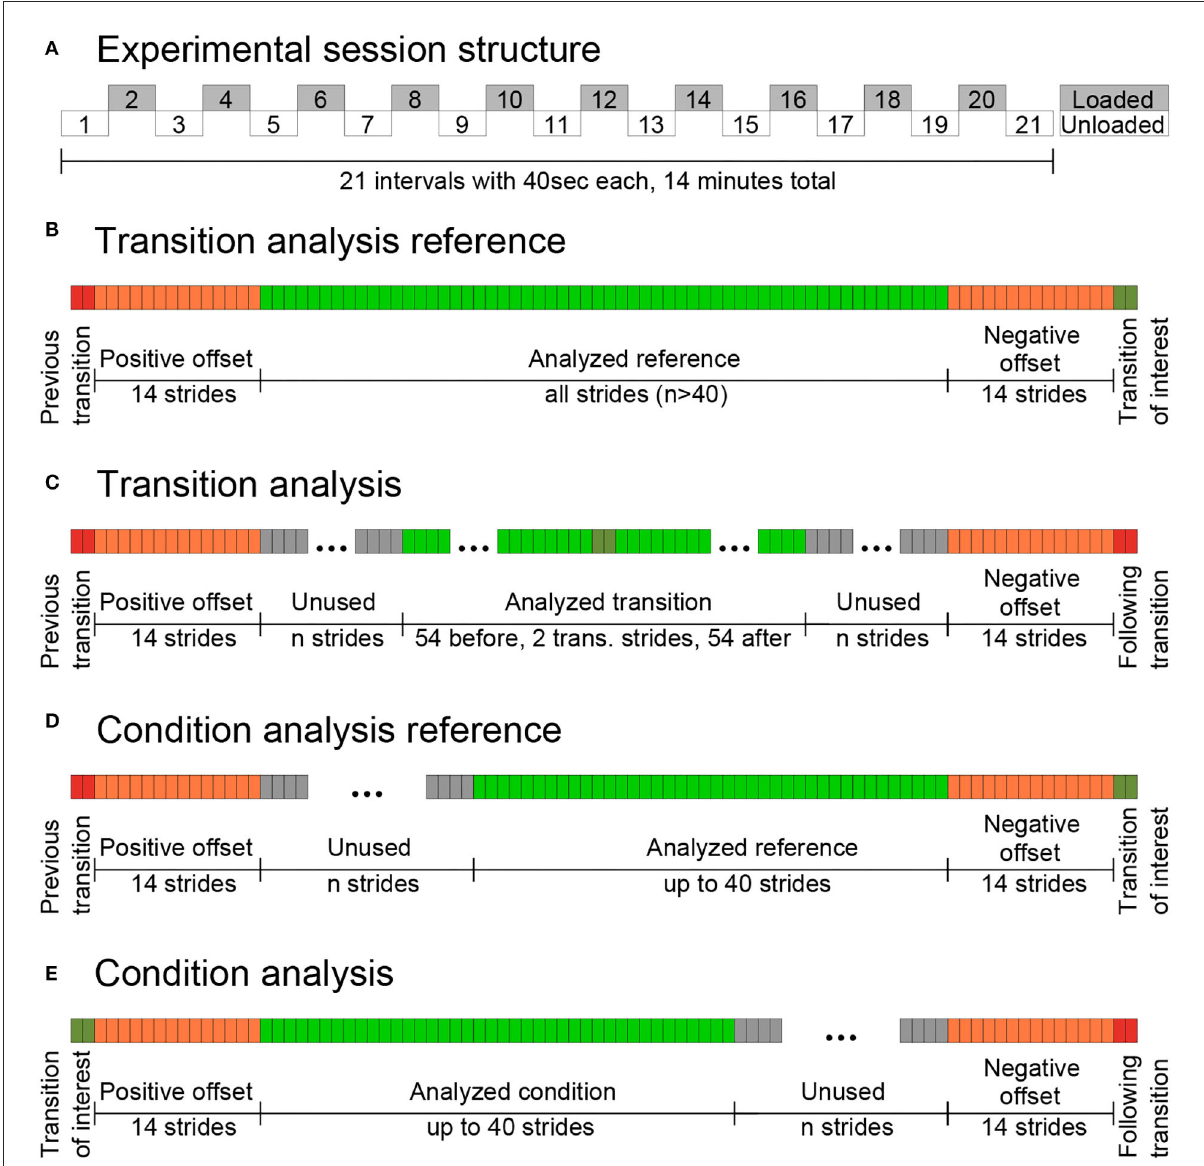
FIGURE3 Experimental session structure for each weight session with 10 transitions to each loaded and unloaded walking (A) , stride selection for the transition reference (B) and the transition analysis (C) , and the stride selection for the condition reference (D) and the condition analysis (E) . Following Warmup session 1, sessions 2–4 included 21 intervals of alternating the loaded and unloaded conditions. For the 20 weight transitions, we first performed a transition analysis to identify and remove the transition strides, and then a condition analysis to evaluate the usability of the EMG from steady gait strides for HITL